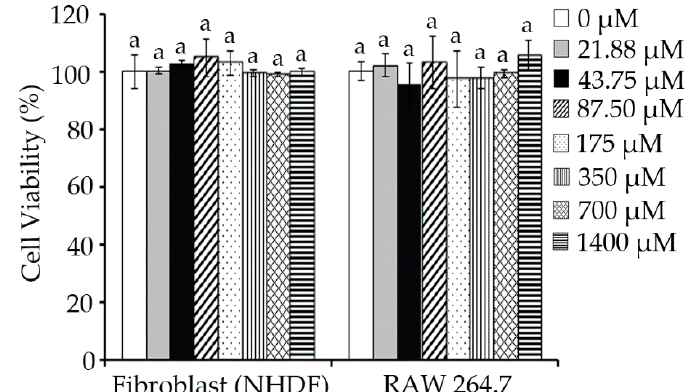
Figure 4. TILI-2 displays negligible cellular cytotoxicity. The cell viability of fibroblast (NHDF) cells and RAW 264.7 cells upon treatment with various concentrations of TILI-2 (0–1400 µM) is shown. All values represent the mean ± SD. Different letters indicate the significant differences from Dun- can’s test ( p <